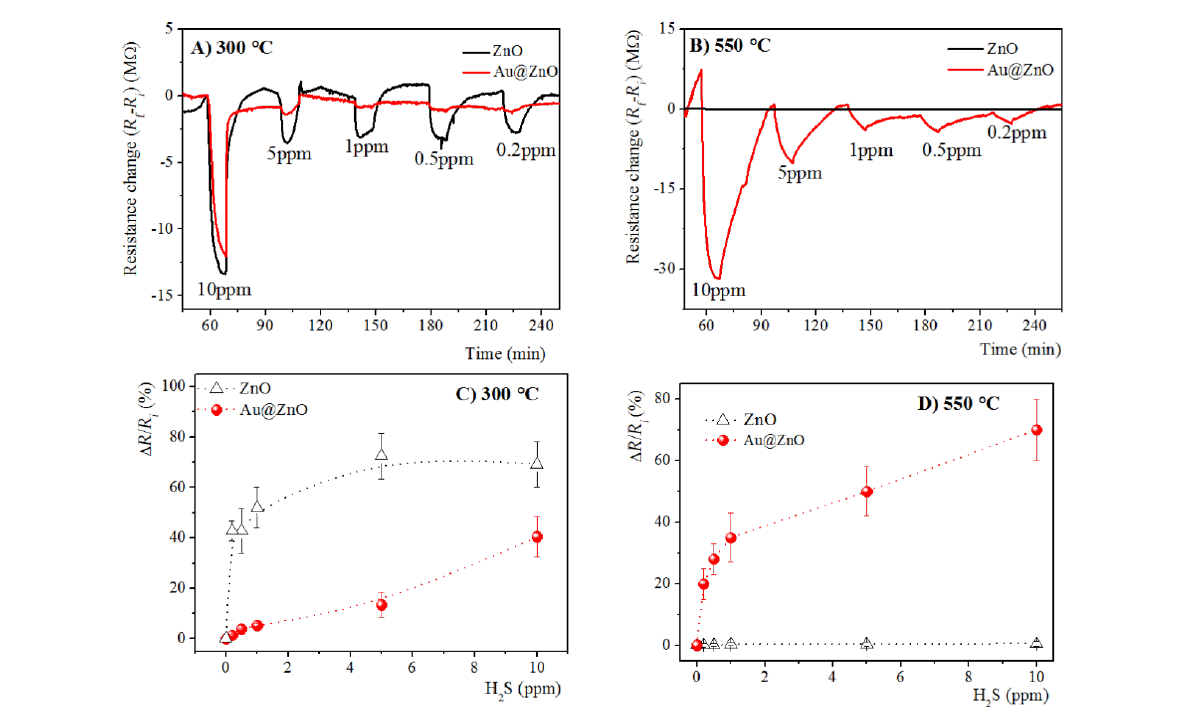
Figure 6: Gas sensor resistance of pristine and Au@ ZnO annealed at A) 300 °C and B) 550 °C over time under exposure to different H 2 S concentra- tions [0.2–10 ppm] at operating temperature of 300 °C. Calibration curves of gas sensors, based on of pristine and Au@ ZnO annealed at C) 300 °C and D) 550 °C, to H 2 S gas [0.2–10 ppm] at an operating temperature of 300 °C.